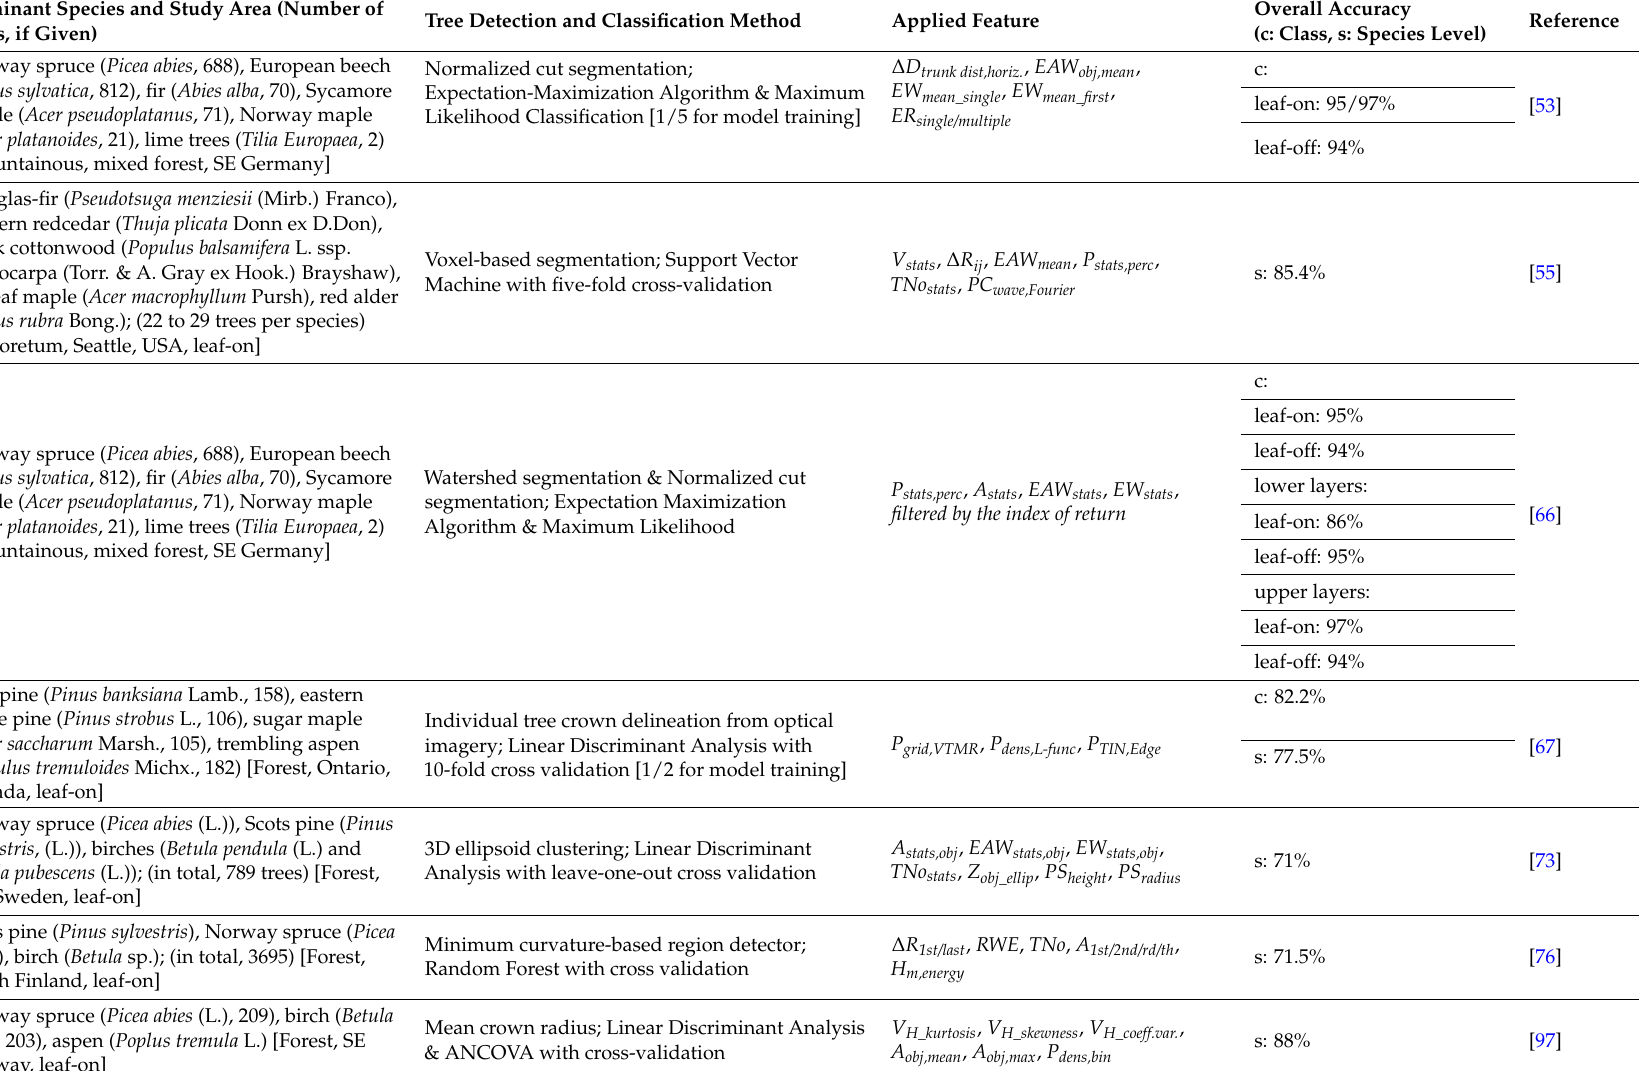
Overall Accuracy (c: Class, s: Species Level)